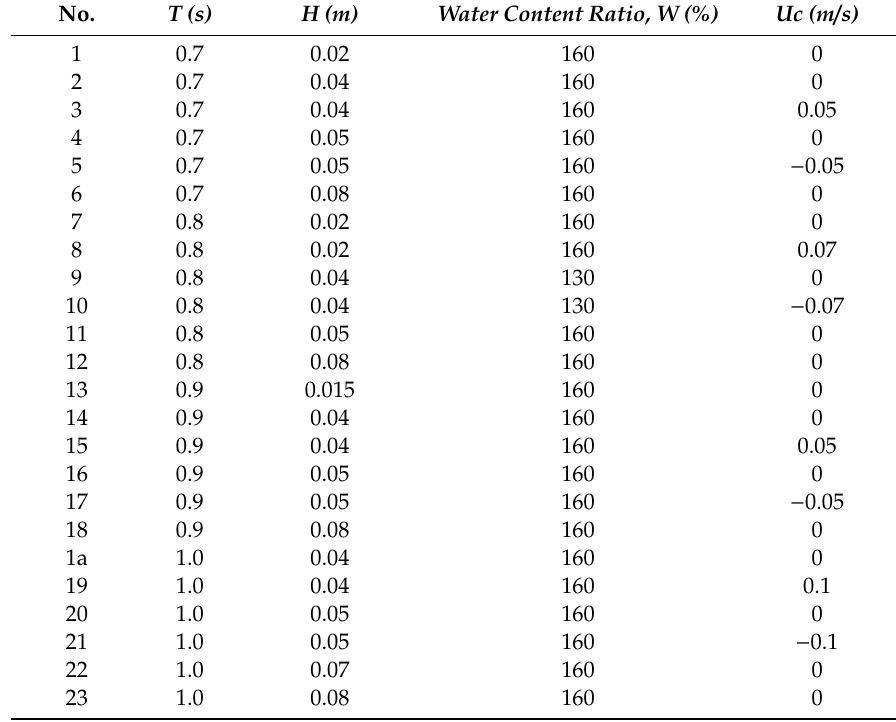
Table 2. Laboratory experimental conditions ( T is the wave period, H the wave height, and U c is the current